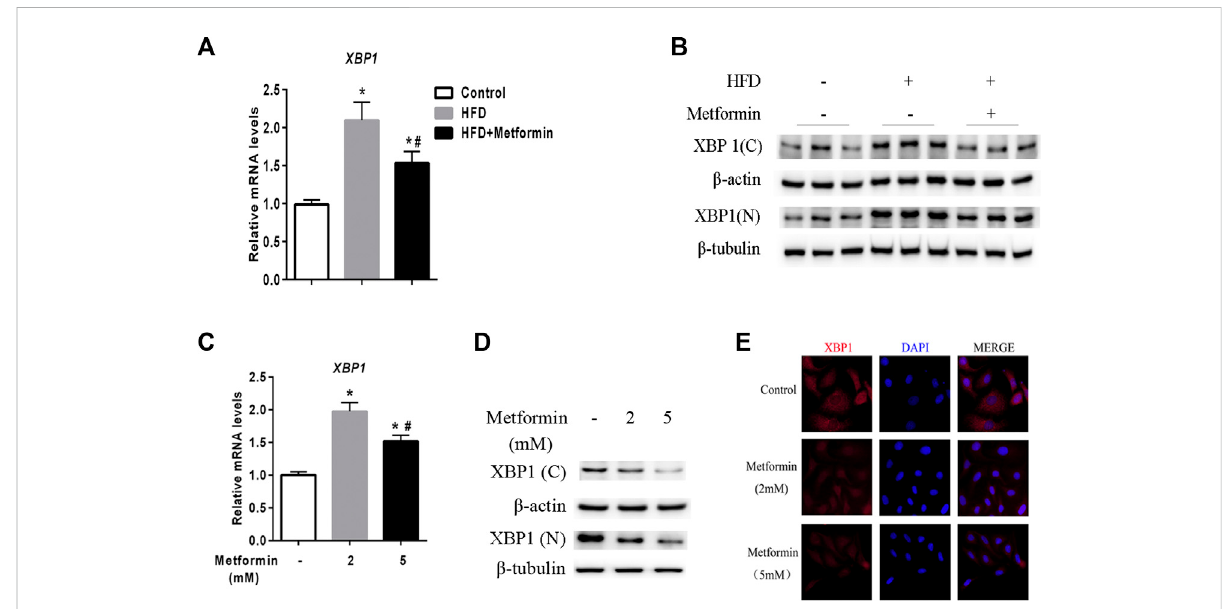
FIGURE 3 Metformin decreased nuclear and cytoplasmic XBP1 levels in the liver. (A) XBP1 gene expression in the liver of the mice fed control diet or HFD with orwithoutmetformin treatment for 5 weeks. (B) Nuclear(N) and cytoplasmic (C) XBP1proteinintheliver ofthemice fedby control dietor HFD with or without metformin treatment for 5 weeks. p p < 0.05 compared with control mice. #p < 0.05 compared with HFD mice, n = 6 – 8. (C) Relative mRNA level, (D) Nuclear (N) and cytoplasmic (C) XBP1 protein levels, and (E) immuno fl uorescence images of XBP1 (red) and nuclear staining with 4 ′ ,6-diamidino-2-phenylindole (DAPI, blue) in HepG2 cells treated with 2 mmol/L or 5 mmol/L metformin for 24 h. Magni fi cation, ×200. Data are presented as the mean ± SEM of at least three independent experiments. p p < 0.05 compared with control cells. #p < 0.05 compared with 2 mmol/L metformin-treated